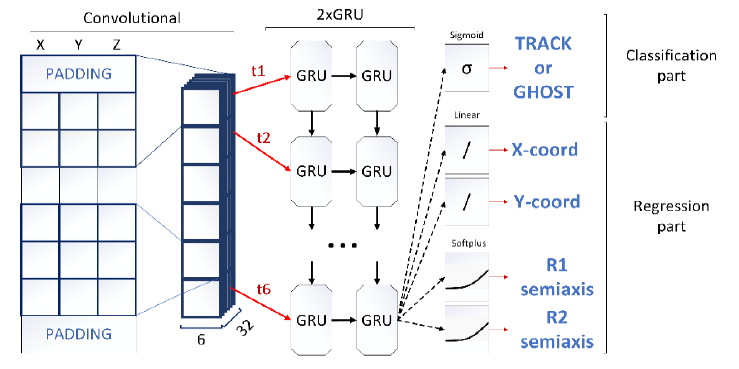
Fig. 1. The scheme of the deep RNN for